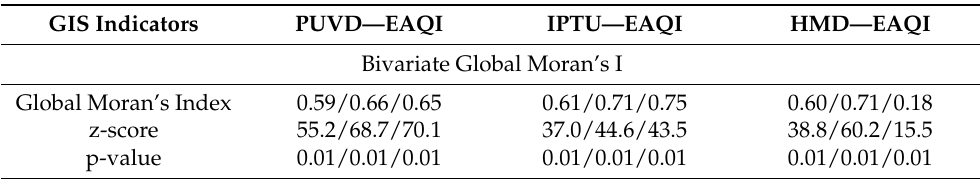
Table 2. Bivariate Global Moran’s I statistics for spatial correlation between mobility indicators and EQI index (data order: